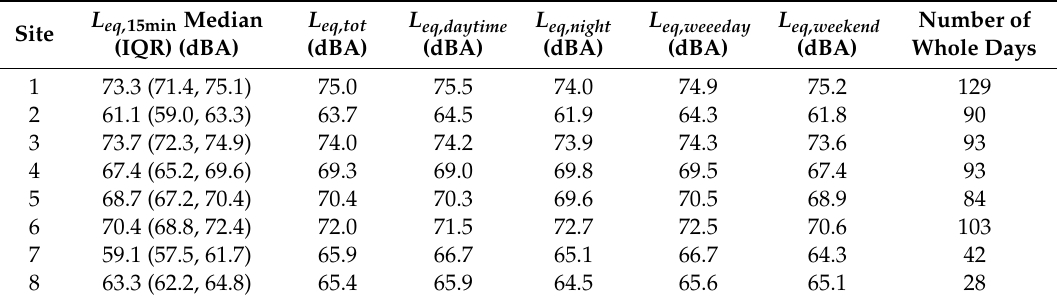
Table 2. Descriptive statistics of sound